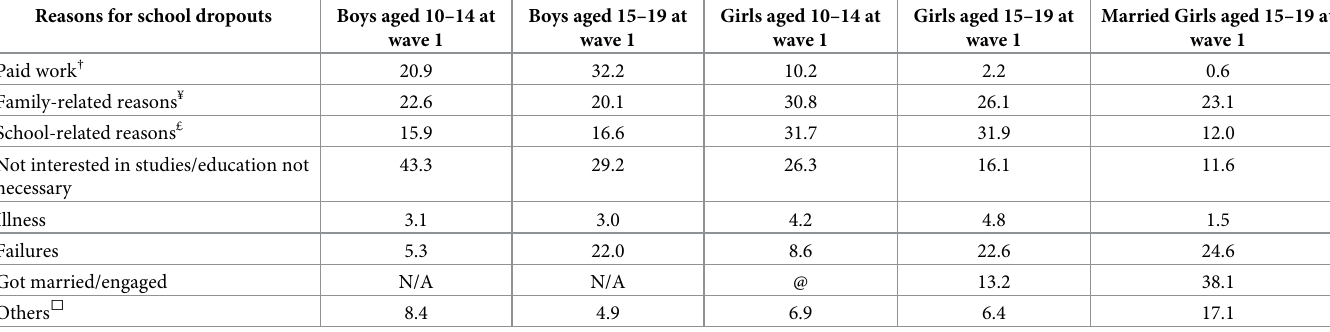
Table 4. Reasons for school dropouts among adolescent boys and girls, and married girls, 2018–19. Reasons for school dropouts